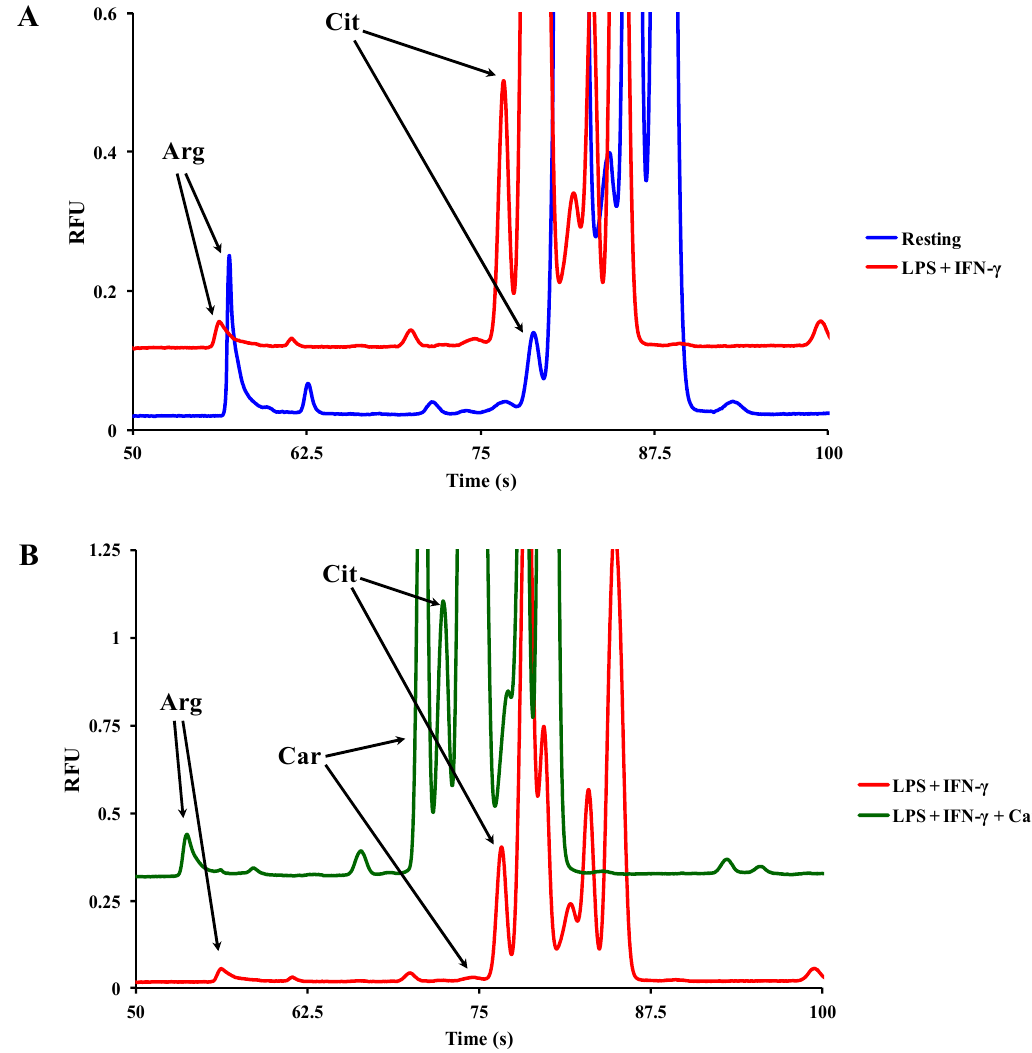
Figure 3. Representative electropherograms of cell lysates showing the change in peak area of Arg, Cit, and carnosine (Car) ( A ) for resting (untreated) macrophages (blue line) and ( B ) for macrophages stimulated with LPS + IFN- γ , in the absence (red line) or in the presence (green line) of carnosine. RFU = relative fluorescent unit.